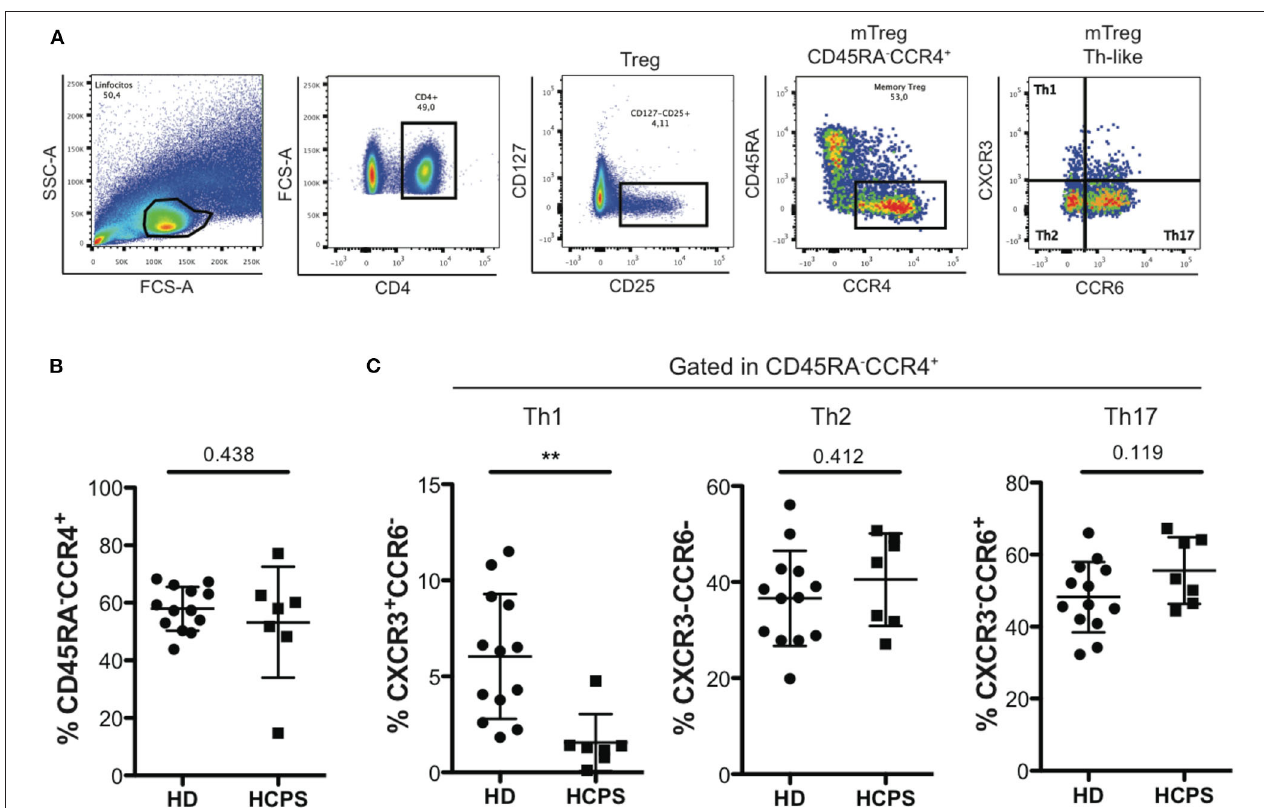
FIGURE 2 | HCPS survivors present a decrease on memory Th1-like Treg. (A) Gating strategy of a representative sample showing the CD4 + T cells, CD127 low / − CD25 + Treg cells, memory Treg CD45RA − CCR4 + , and finally the memory Th-like Treg subpopulations, specifically Th1-like Treg (CXCR3 + CCR6 − ), Th2-like Treg (CXCR3 − CCR6 − ), and Th17-like Treg (CXCR3 − CCR6 + ). (B) Frequency of memory Treg CD45RA − CCR4 + in HD and HCPS. (C) Frequency of Th1-like, Th2-like, and Th17-like memory Treg in HD and HCPS. Data represented as dots (HD n = 13) and squares (HCPS n = 7), indicating the mean ± SD. ** P = 0.003 by unpaired Student’s t